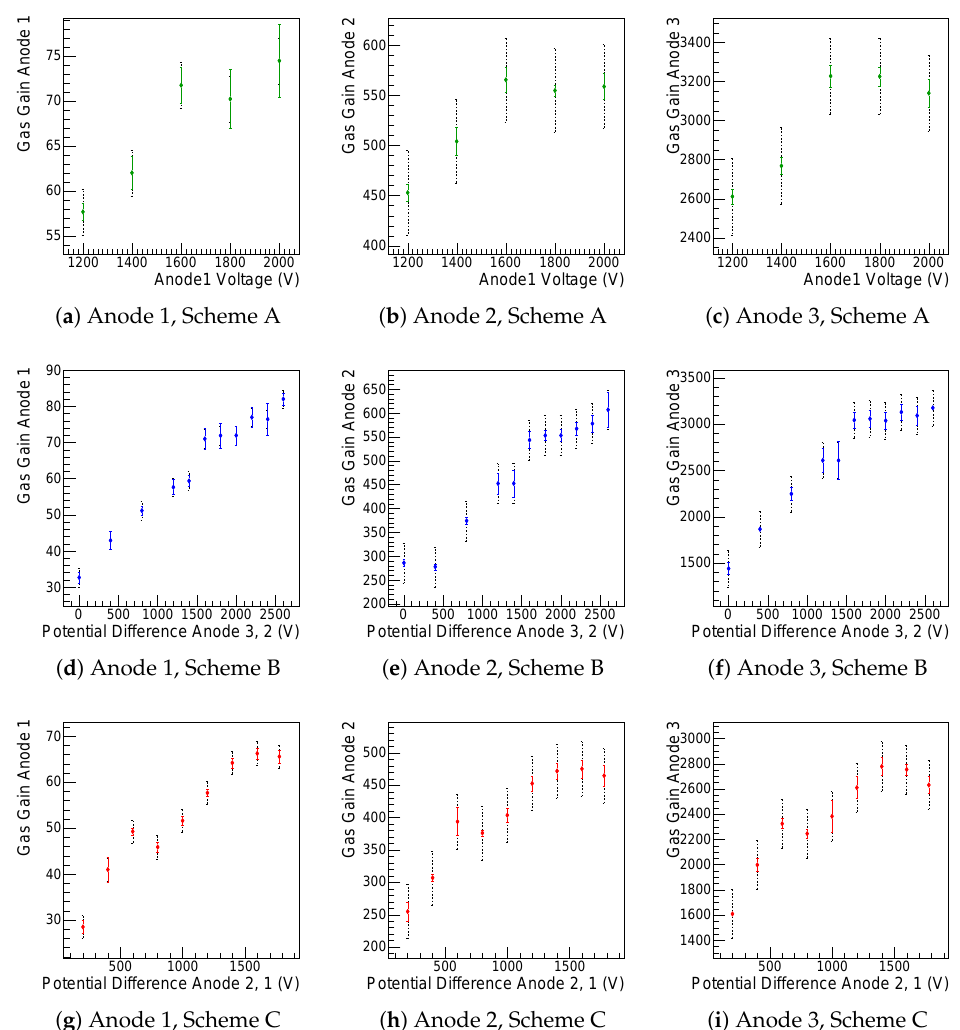
Figure 22. Plots of the calculated gas gain vs. either anode voltage or inter-anode voltage difference. The gain is calculated from the data shown in the respective plot in Figure 21. First row ( a – c ): Scheme A, gain vs. anode 1 voltage ( V a 1 ), V a 1 , V a 2 , and V a 3 are increased by the same amount, whilst ∆